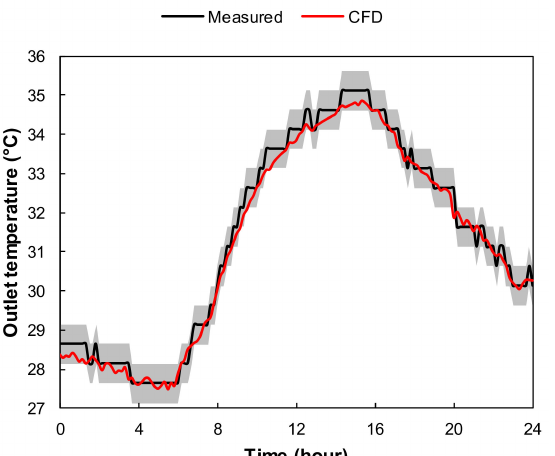
Figure 7. Comparison between measured and numerically predicted outlet temperature of the EAHE. The gray shading indicates the uncertainty of the measurements ( ± 0.5 ◦